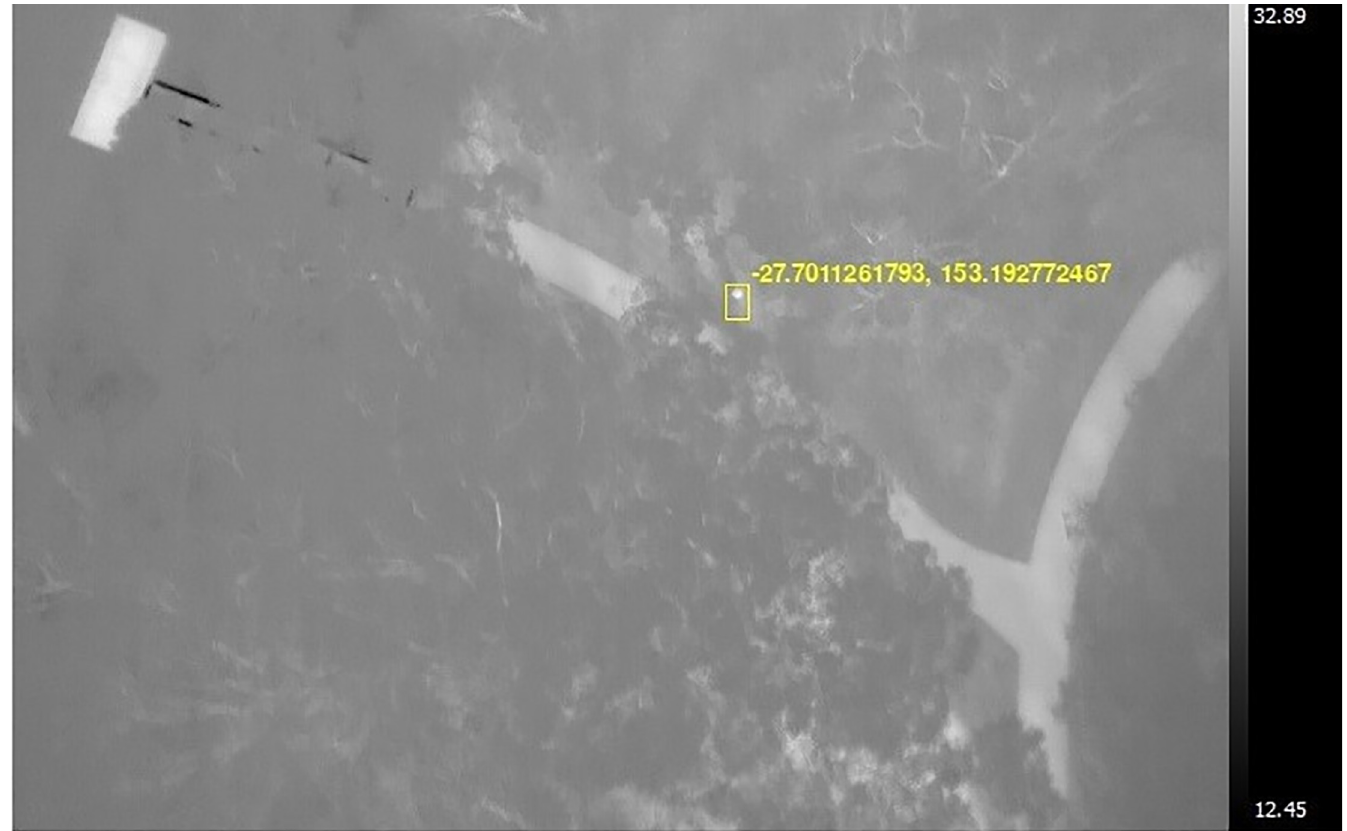
Fig 1. Airborne thermal image. Example of a thermal image of a koala captured by the Remotely-Piloted Aircraft Systems during thermal-imagery surveying of the study area.